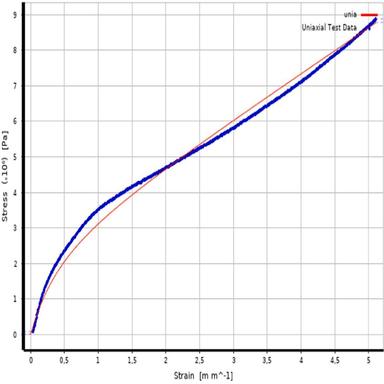
Uniaxial data fitting Mooney Rivlin – 2 parameter hyperelastic model.